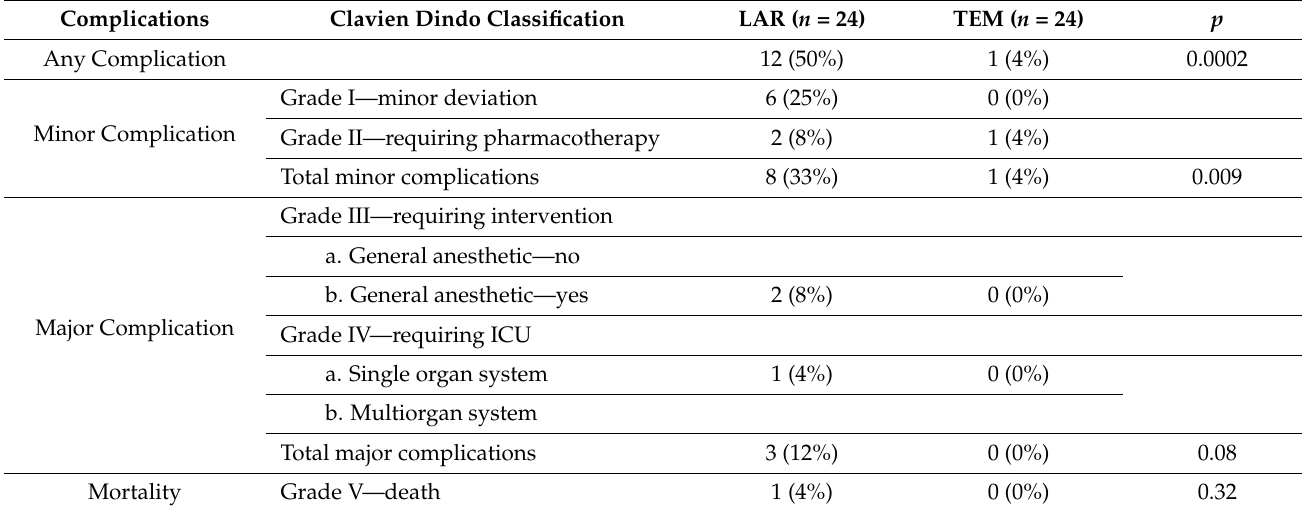
Table 2. Summary of complications.